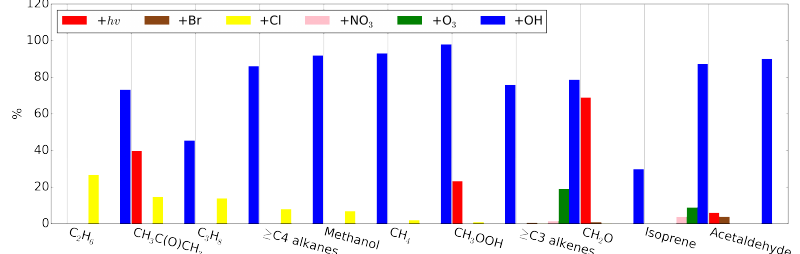
Figure 16. Global loss routes ( + hν , + Br, + NO 3 , + Cl, + O 3 , + OH) of organic compounds shown as % of total tropospheric losses.